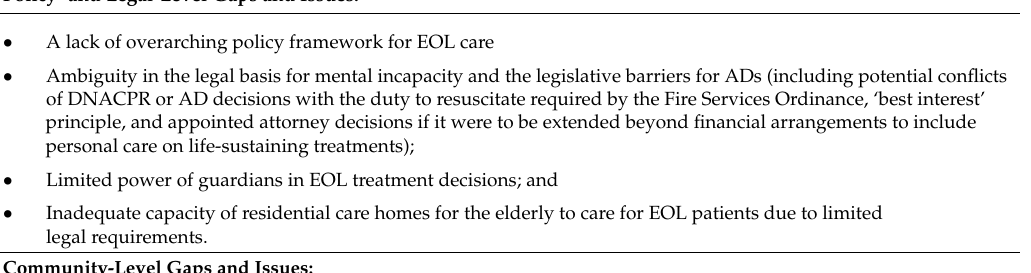
Table 1. Gaps and issues of end-of-life (EOL) for terminal illness and life-limiting conditions among older persons in Hong